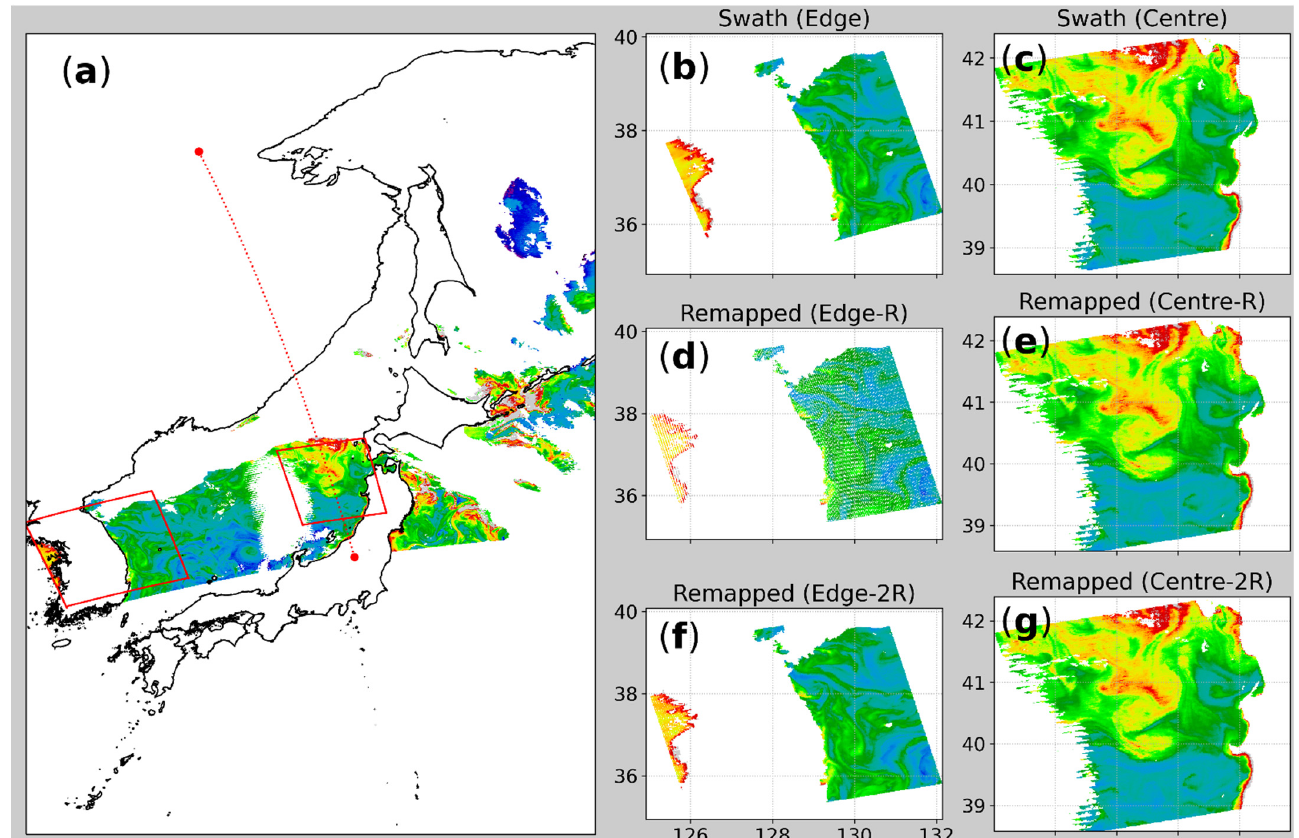
Figure 2. Reprojection of swath data for the MODIS/Aqua file (Table 1). ( a ) Swath image with the nadir track shown as red dotted line. ( b , c ) Swath subset data from the red polygon at the swath edge ( b ) and at the nadir view ( c ). ( d , e ) Reprojected data with cutoff distance (radius of influence) equal to the spatial resolution (R) for swath edge ( d ) and nadir view ( e ). ( f , g ) Same as ( d , e ) but for the cutoff distance equal to 2R. The red dots at the start and end of the dotted line indicate the swath start and end center positions, respectively. The reprojection was done using the NN method. The impact of using R ( d ) versus 2R ( f ) was evident at the swath edge. A similar example is also given for SGLI/GCOM-C in Figure A6.